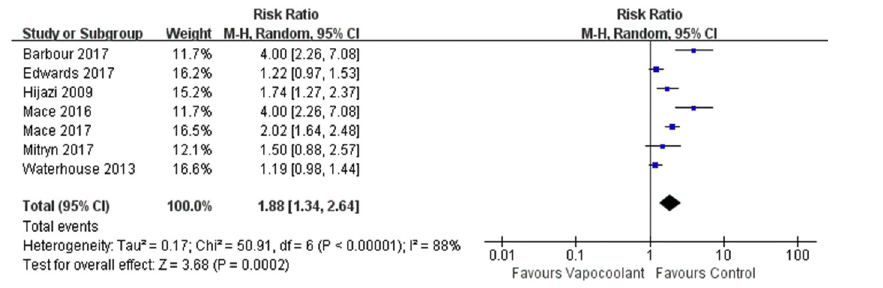
Fig 10. Forest plot of patient’s attitude.